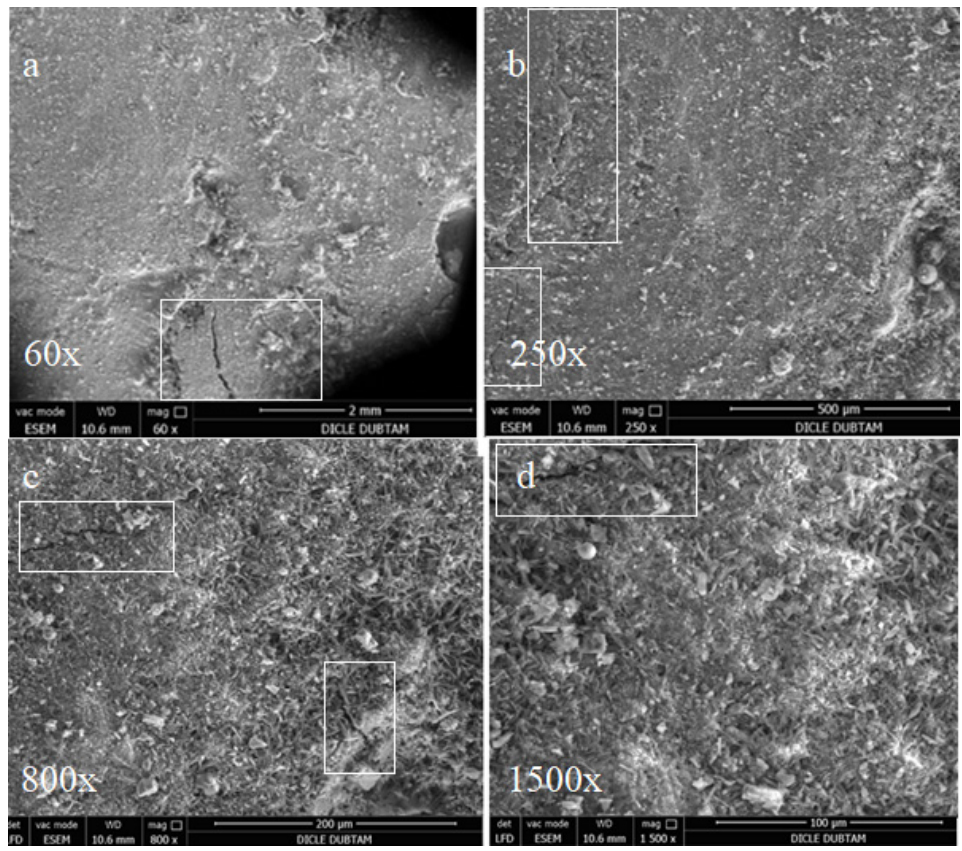
Figure 16. SEM images of FA replacement bar samples cured for 90 days in sulphate solution ( a ) 60×; ( b ) 250×; ( c ) 800×; ( d ) 1500×.